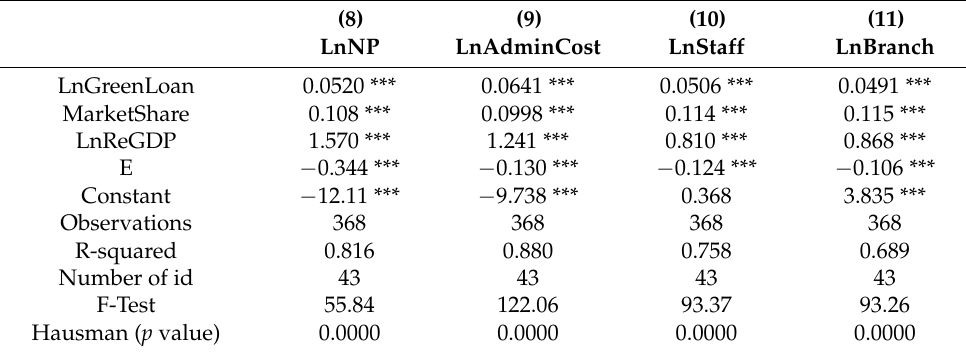
Table 3. Regression of green credit on costs and